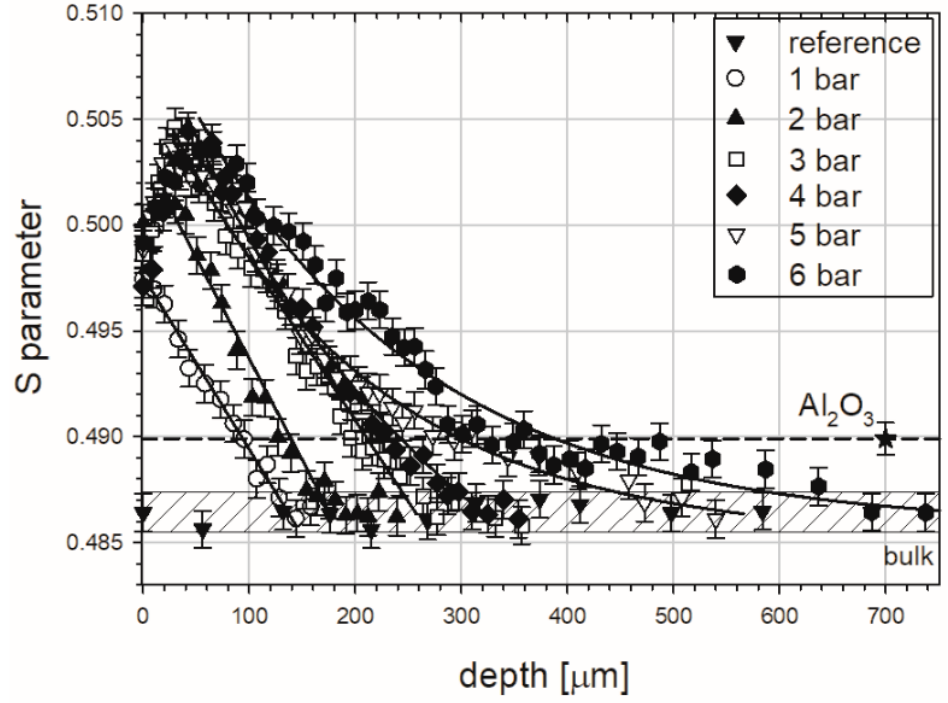
Figure 7. S parameter dependent on the depth for the well-annealed copper samples sandblasted with alumina particles at different pressures. The drop line marks the value of the S parameter obtained for pure alumina. The solid lines represent the best fits of linear or exponential decay functions to decreasing parts of measured profiles.